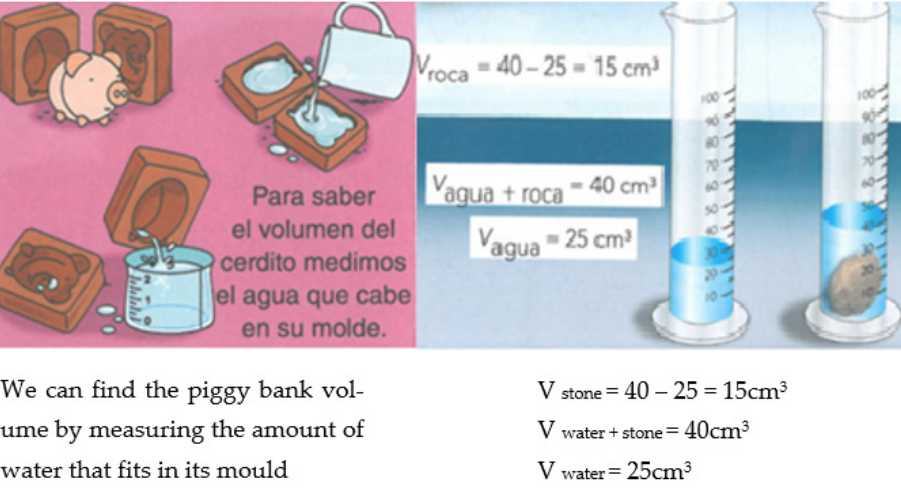
Figure 7. Volume measurement in second and sixth year Anaya science books [46,47].